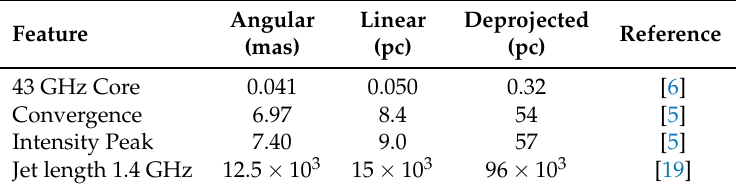
Table 2. Conversion of angular sizes to linear and deprojected sizes.